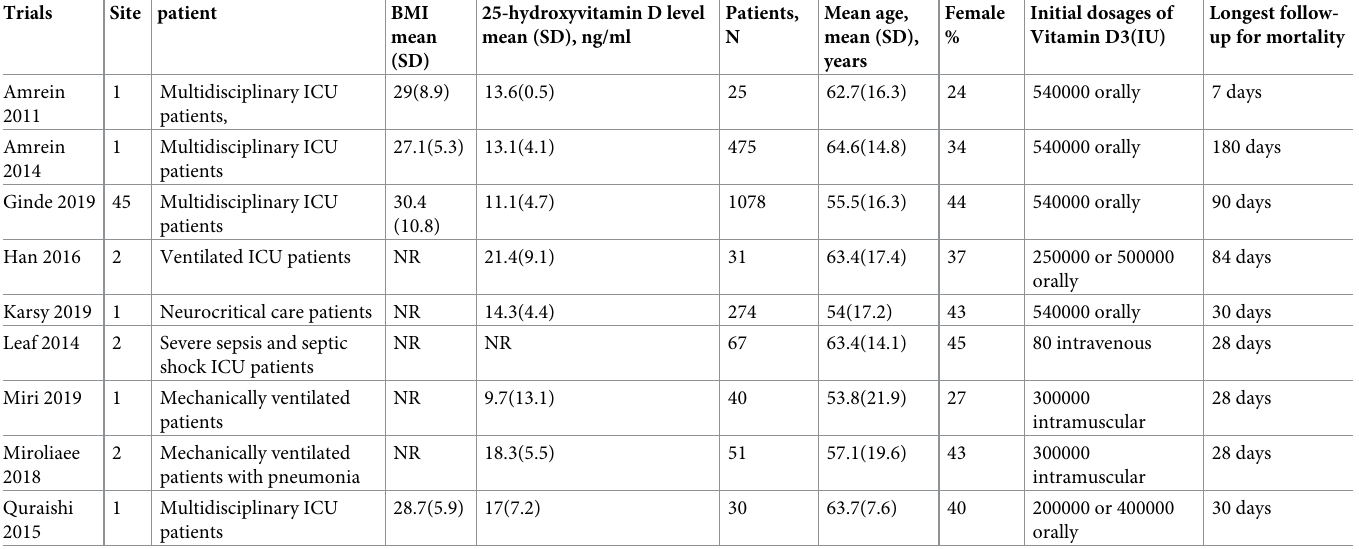
Table 1. Characteristics of studies included in the systematic review of vitamin D supplement in critically ill